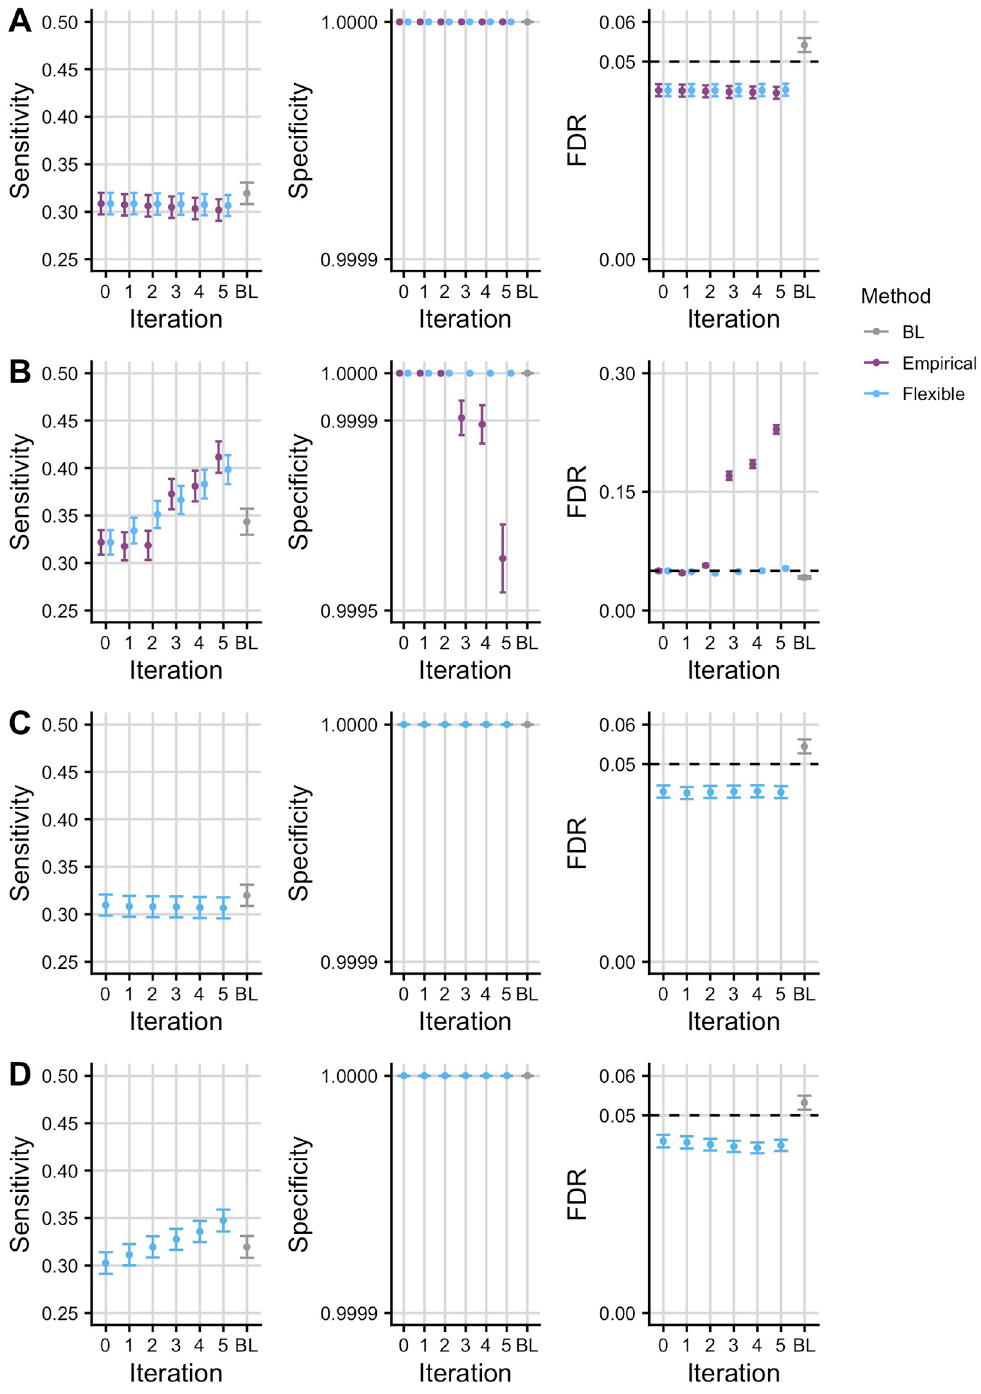
Fig 1. Simulation results. Mean +/- standard error for the sensitivity, specificity and FDR of FDR values from empirical and Flexible cFDR when iterating over independent (A; “simulation A”) and dependent (B; “simulation B”) auxiliary data that is bounded by [0, 1]. Panels C and D show the results from Flexible cFDR when iterating over independent (C; “simulation C”) and dependent (D; “simulation D”) auxiliary data simulated from bimodal mixture normal distributions. BL refers to results when using Boca and Leek’s FDR regression to leverage the 5-dimensional covariate data. Iteration 0 corresponds to the original FDR values. Our sensitivity proxy is calculated as the proportion of SNPs with r 2 � 0.8 with a causal variant (“truly associated”), that were detected with a FDR value less than 5 × 10 − 6 . Our specificity proxy is calculated as the proportion of SNPs with r 2 � 0.01 with all the causal variants (“truly not-associated”), that were